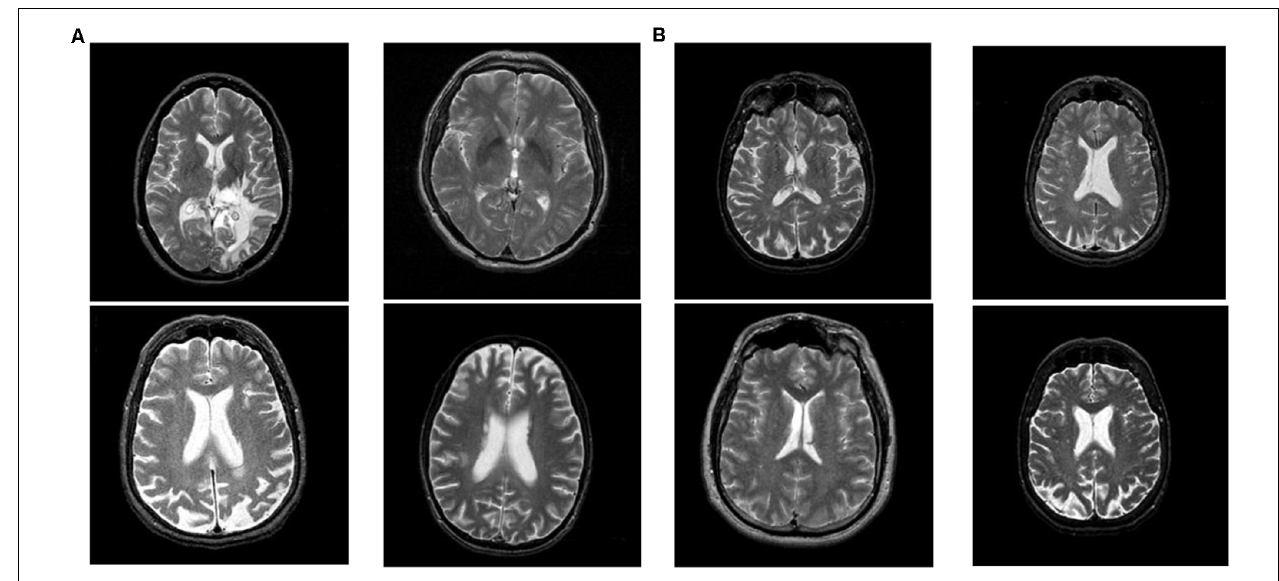
FIGURE 1 | (A) Unhealthy and (B) healthy brain images in the dataset.